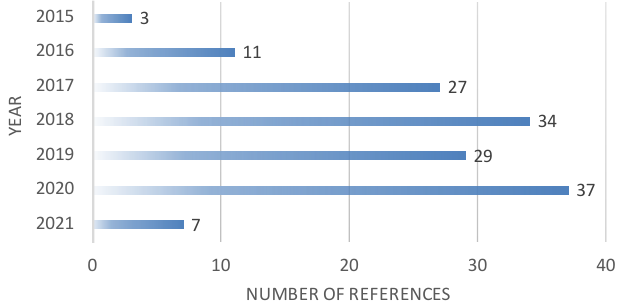
Figure 5. Frequency of peer-reviewed papers in the search